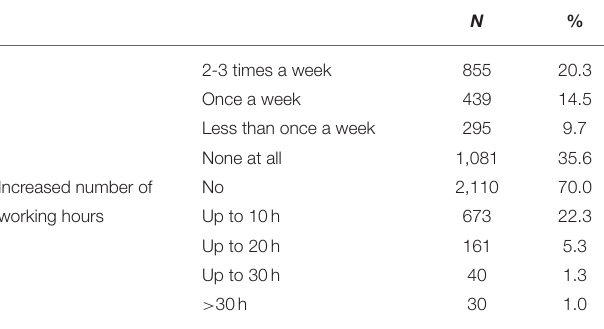
TABLE 1 | Demographic, social and work characteristics.